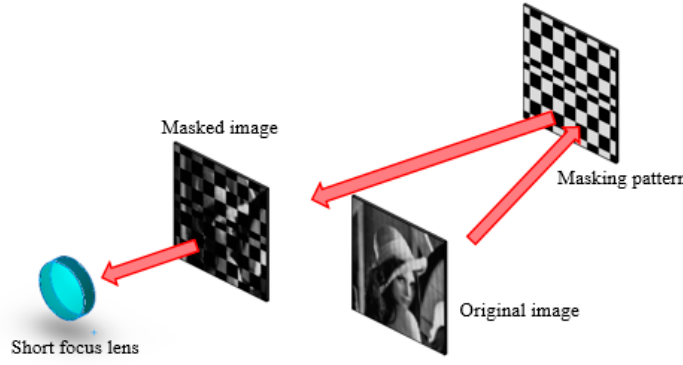
Figure 5. Process of image transformation. The short-focus lens collected the light into a small area on the focal plane. The focal length of the short-focus lens was 8 mm in this case.